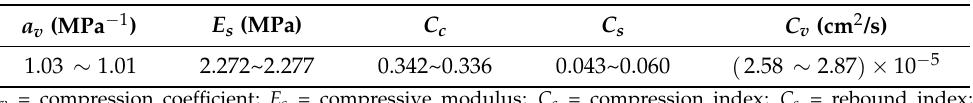
Table 2. Results of consolidation test.